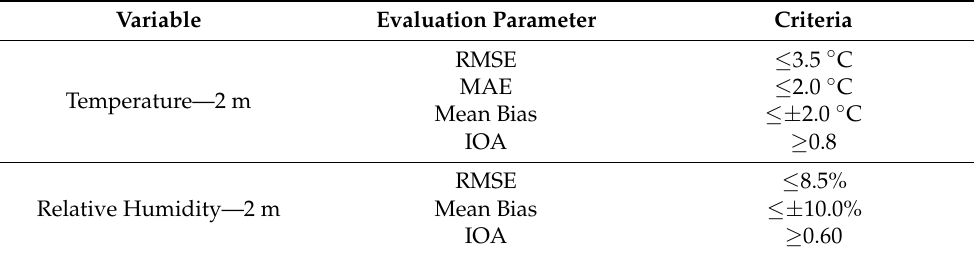
Table 3. Recommended values of statistical tests for the near surface variables adopted in this